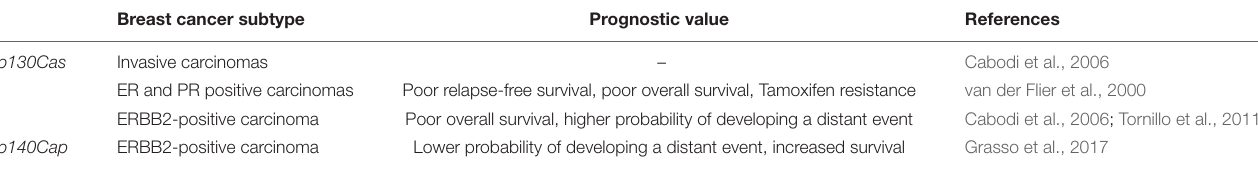
TABLE 1 | Expression and prognostic value of p130Cas and p140Cas in breast cancer. Breast cancer